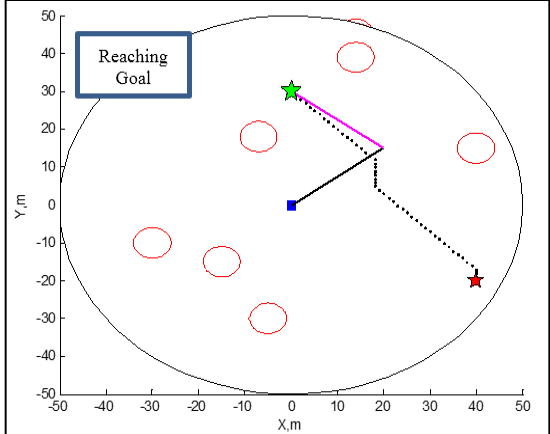
Fig. 13. The two-link robot arm result for the D* path for the second environment